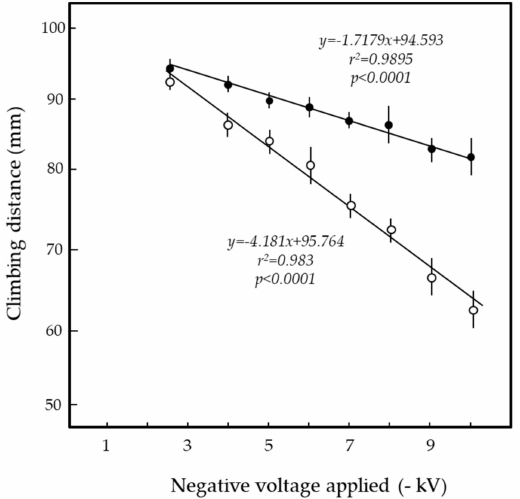
Figure 5. Pole-climbing behavior by rice weevils (closed circles) and cigarette beetles (open circles) placed in the electric field of the insulated ring-shaped rod (ICR) negatively charged with di ff erent voltages. A regression line was generated by plotting the points. Twenty adult insects were used per experiment, and the means and standard deviations were calculated from five experimental